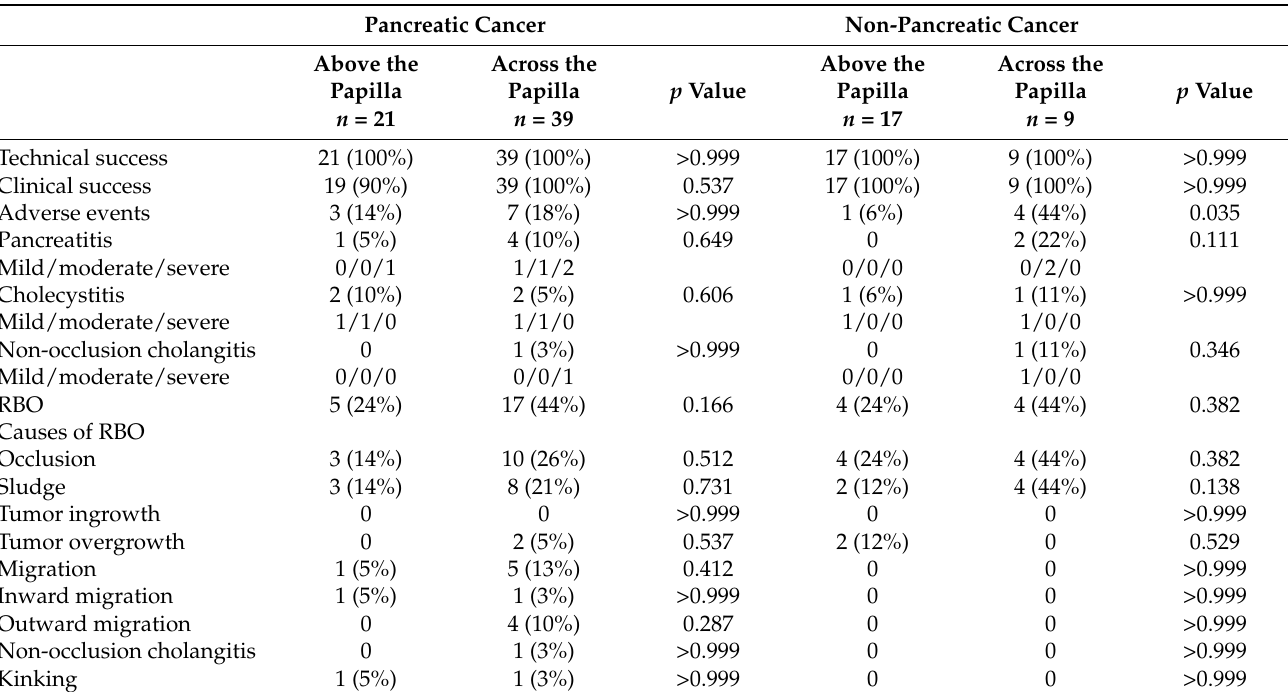
Table 3. Outcomes of covered metal stents placed above and across the papilla, stratified by primary disease